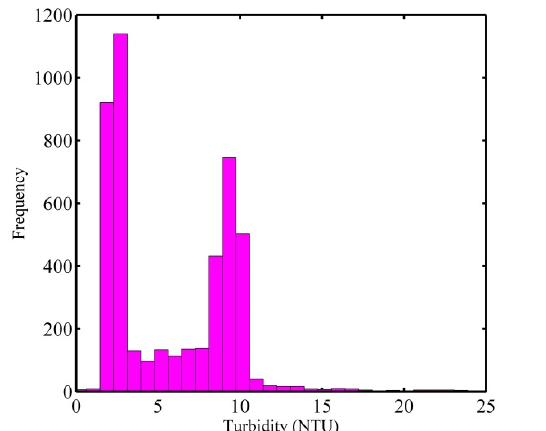
Figure 8. Distribution of turbidity data for the Blue/Colorado River confluence. An